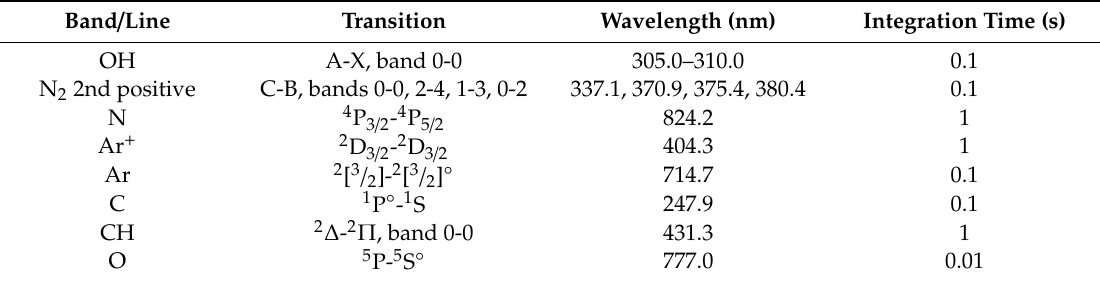
Table 2. Emission bands / lines and their corresponding transitions, wavelengths, and selected integration time. Band /